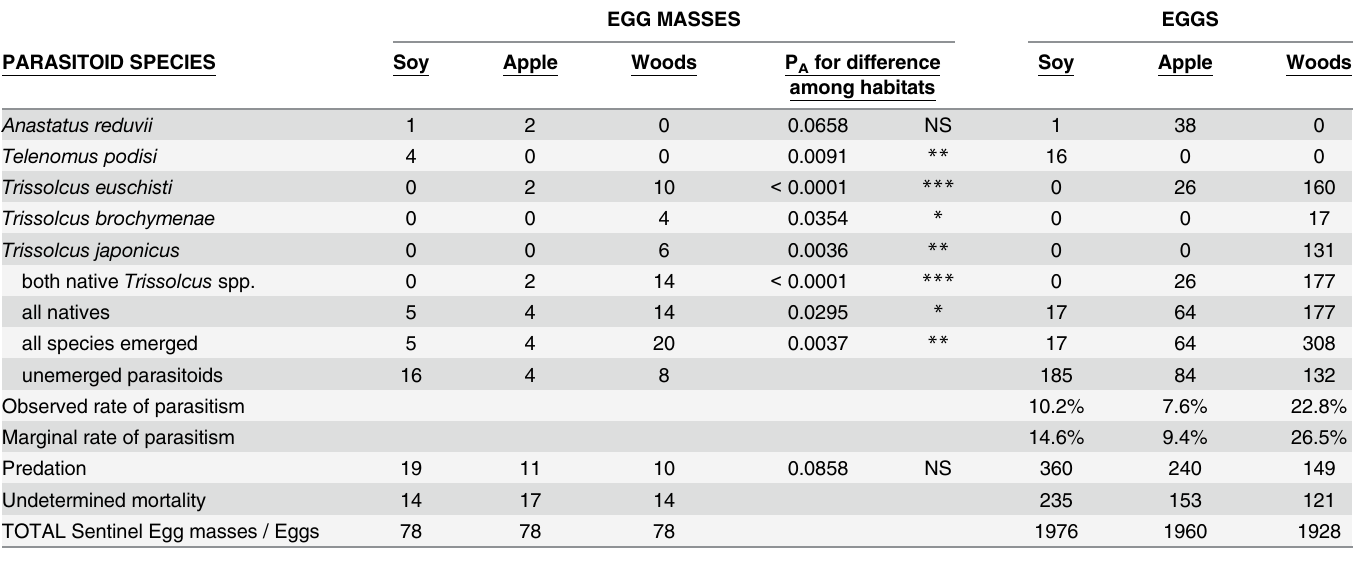
Table 2. Occurrence of successful egg parasitism by species, with tests for differences among habitats, including both fresh and frozen sentinel eggs.